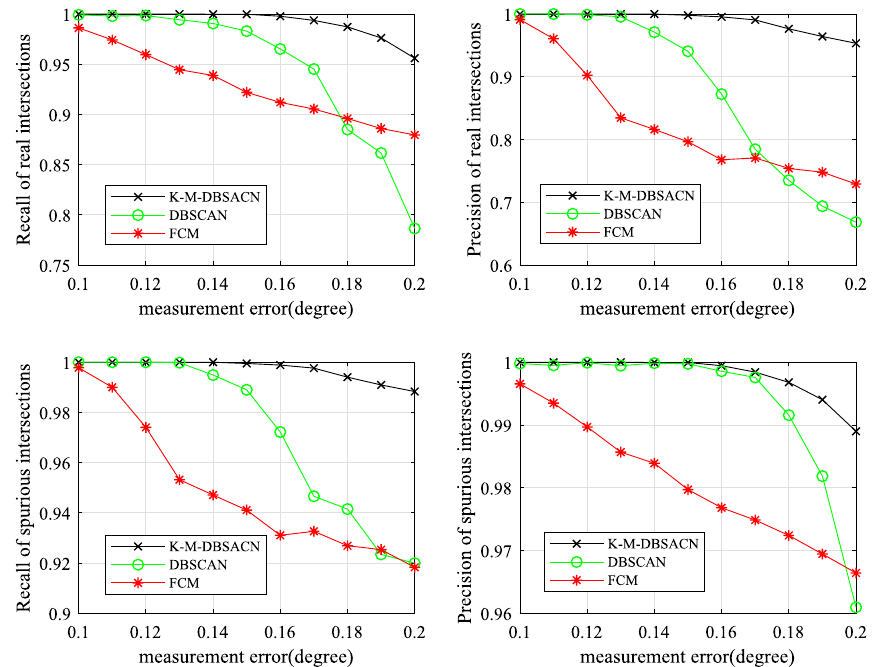
Fig. 5 Comparison of recall and precision versus the measurement error of